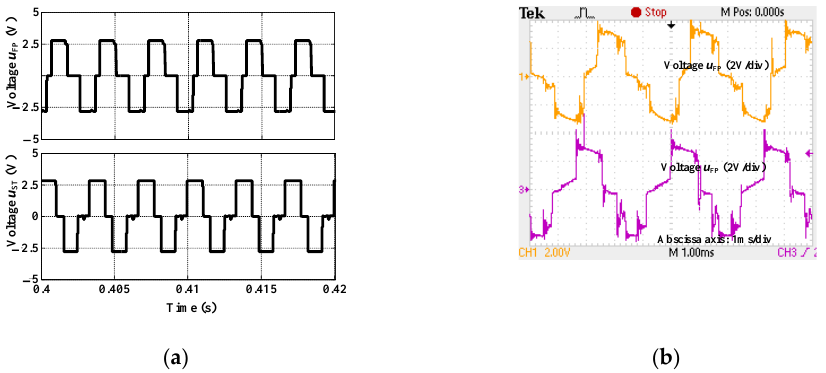
Figure 17. Voltage across the primary winding of the injection transformer. ( a ) Simulation result. ( b ) Experimental result.